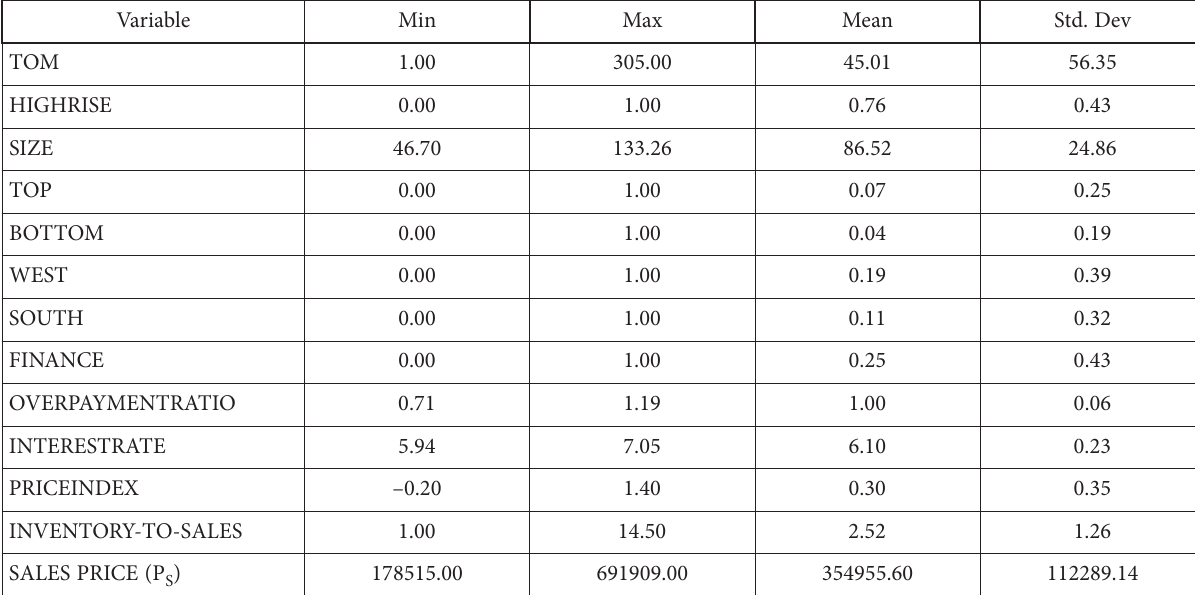
Table 2. Variable summary